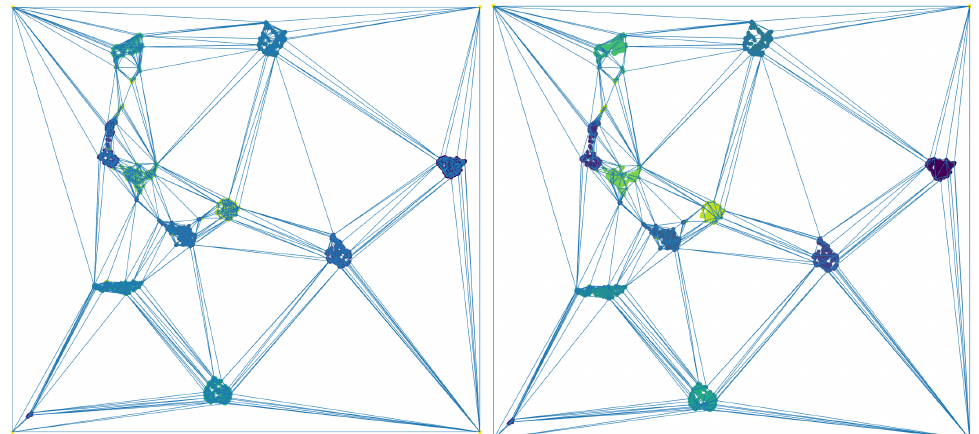
Figure 6. On the ( left ), the Delaunay triangulation of the original data set and, on the ( right ), the Delaunay triangulation of the simplified data set. Table 1. The size of the data set used in the digits experiment, the number of 2-simplices obtained after computing the Delaunay triangulation, and the ones obtained after applying Algorithm 1. Data Set Size